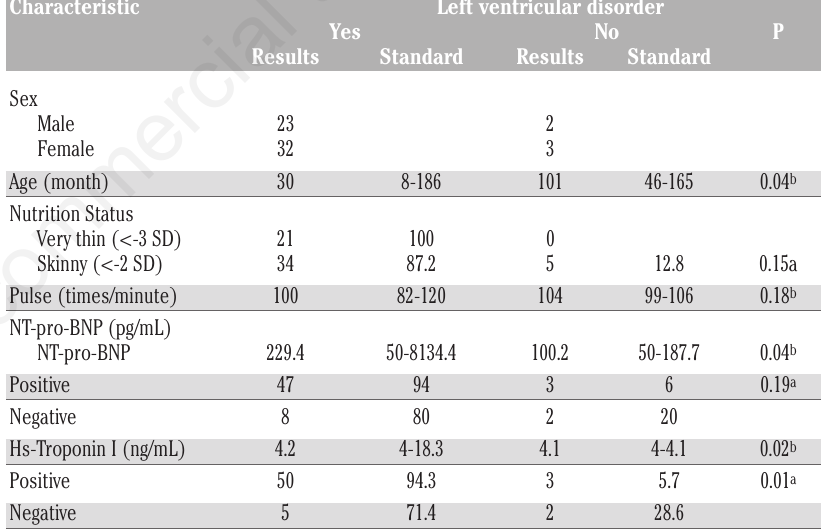
Table 3. Bivariate analysis of several indices against impaired left ventricular function.